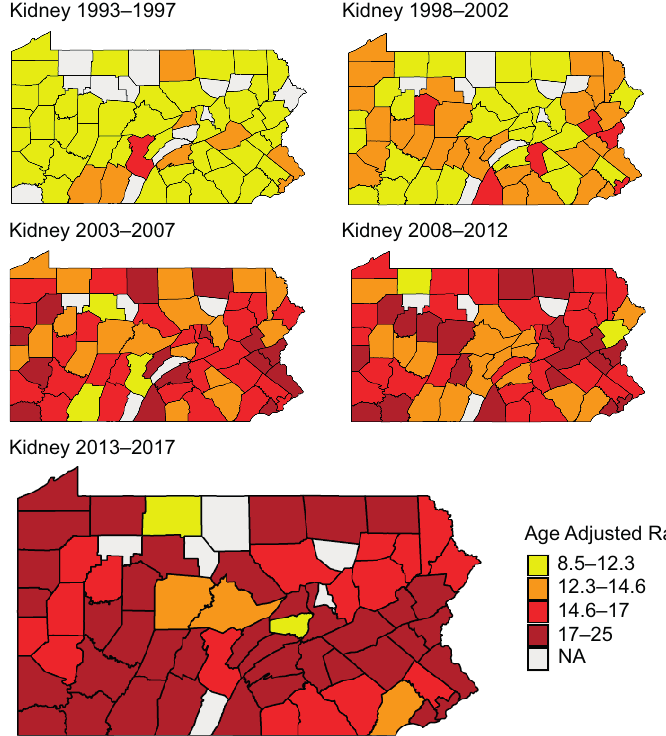
Figure 4: Age-adjusted RCC incidence rates by county in 5-year intervals,